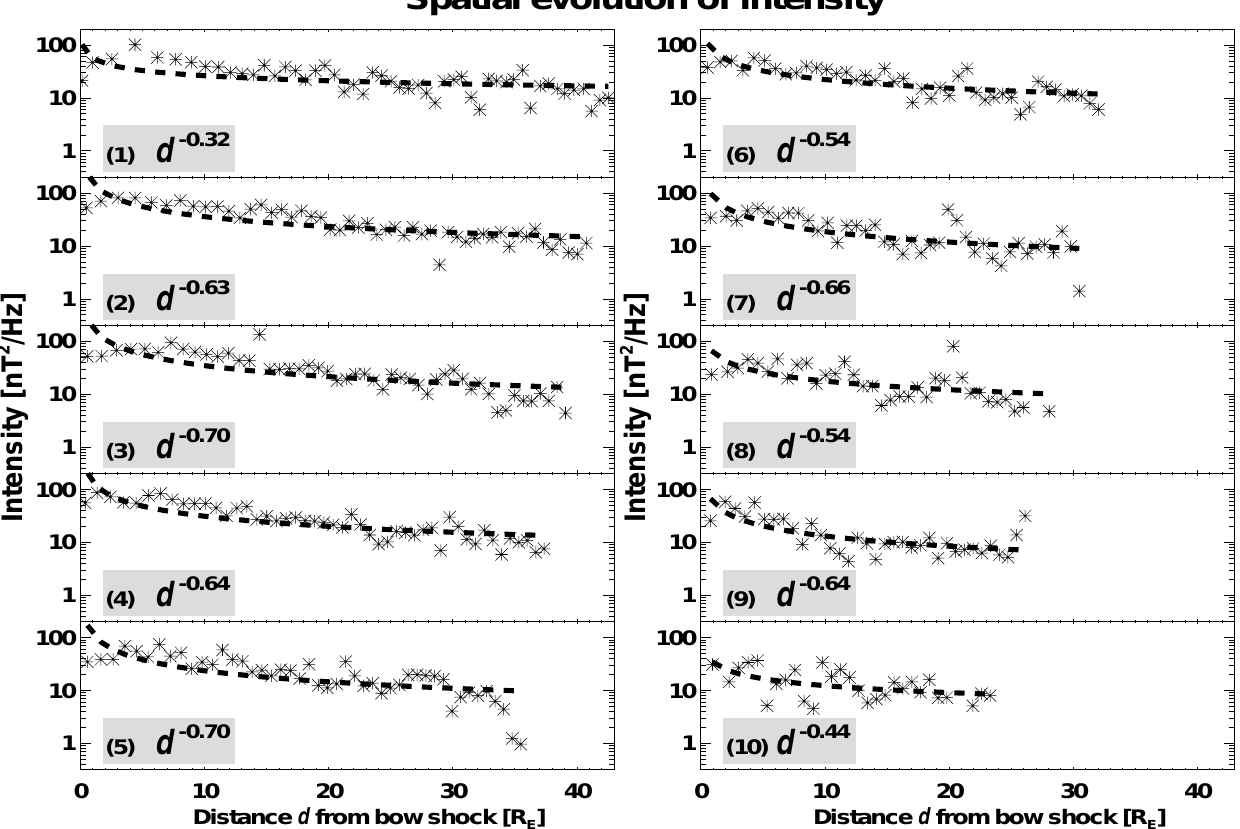
Fig. 9. Wave intensity as function of distance from bow shock. Numbers in parentheses indicate the spatial evolution curve of the associated streamline in Fig. 7. The asterisks denote the calculated intensity values along a streamline and the dashed lines are power law fits to the intensity values. The exponent of the power law represents thus the strength of the decay and varies between − 0 . 32 and − 0 . 70 indicated by d β